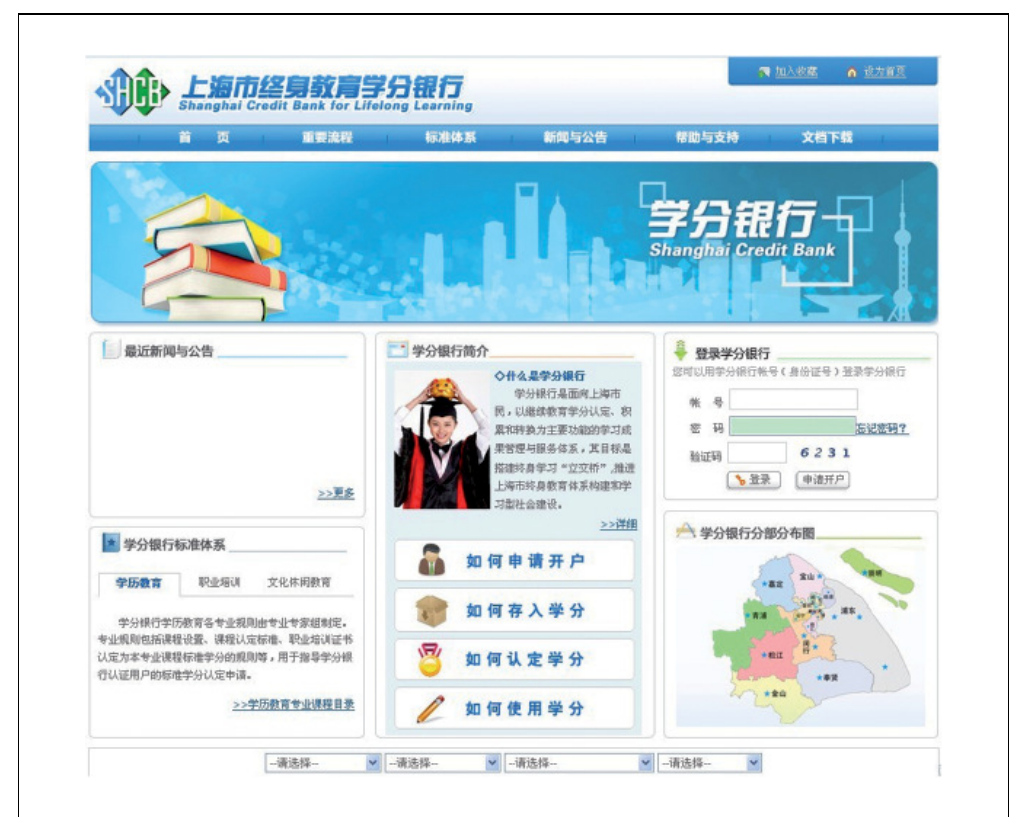
Figure 2 The website of the SHCB (Shanghai Academic Credit Transfer and Accumulation Bank for Lifelong Education,